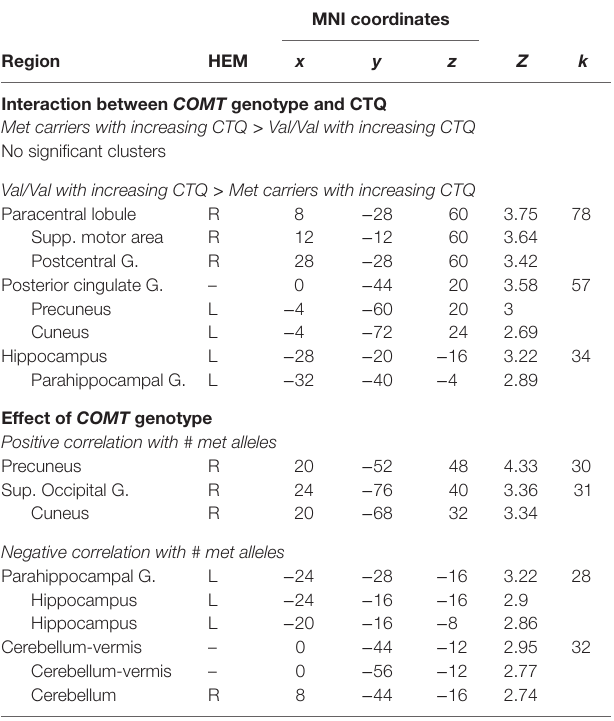
TaBle 3 | results of whole brain analyses.